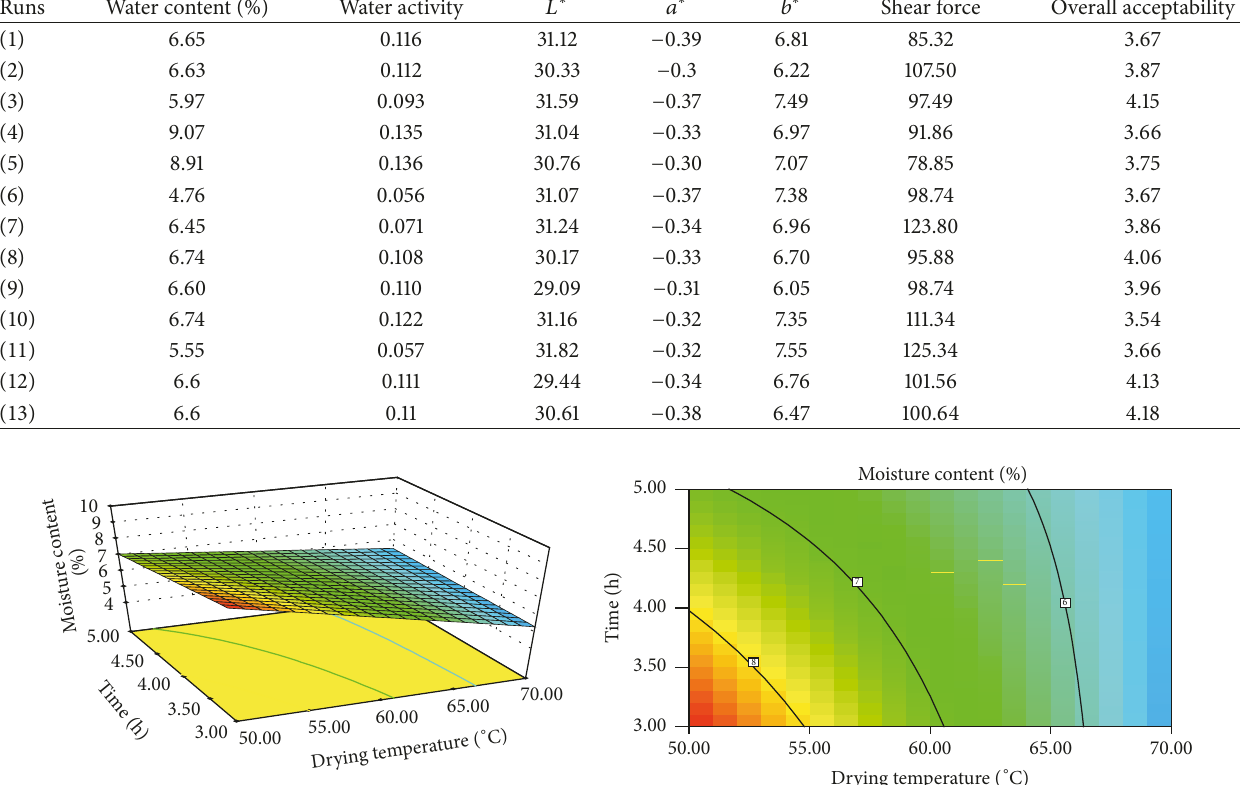
Figure 2: 3D response surface and contour plots for the effect of drying temperature and time on moisture content of